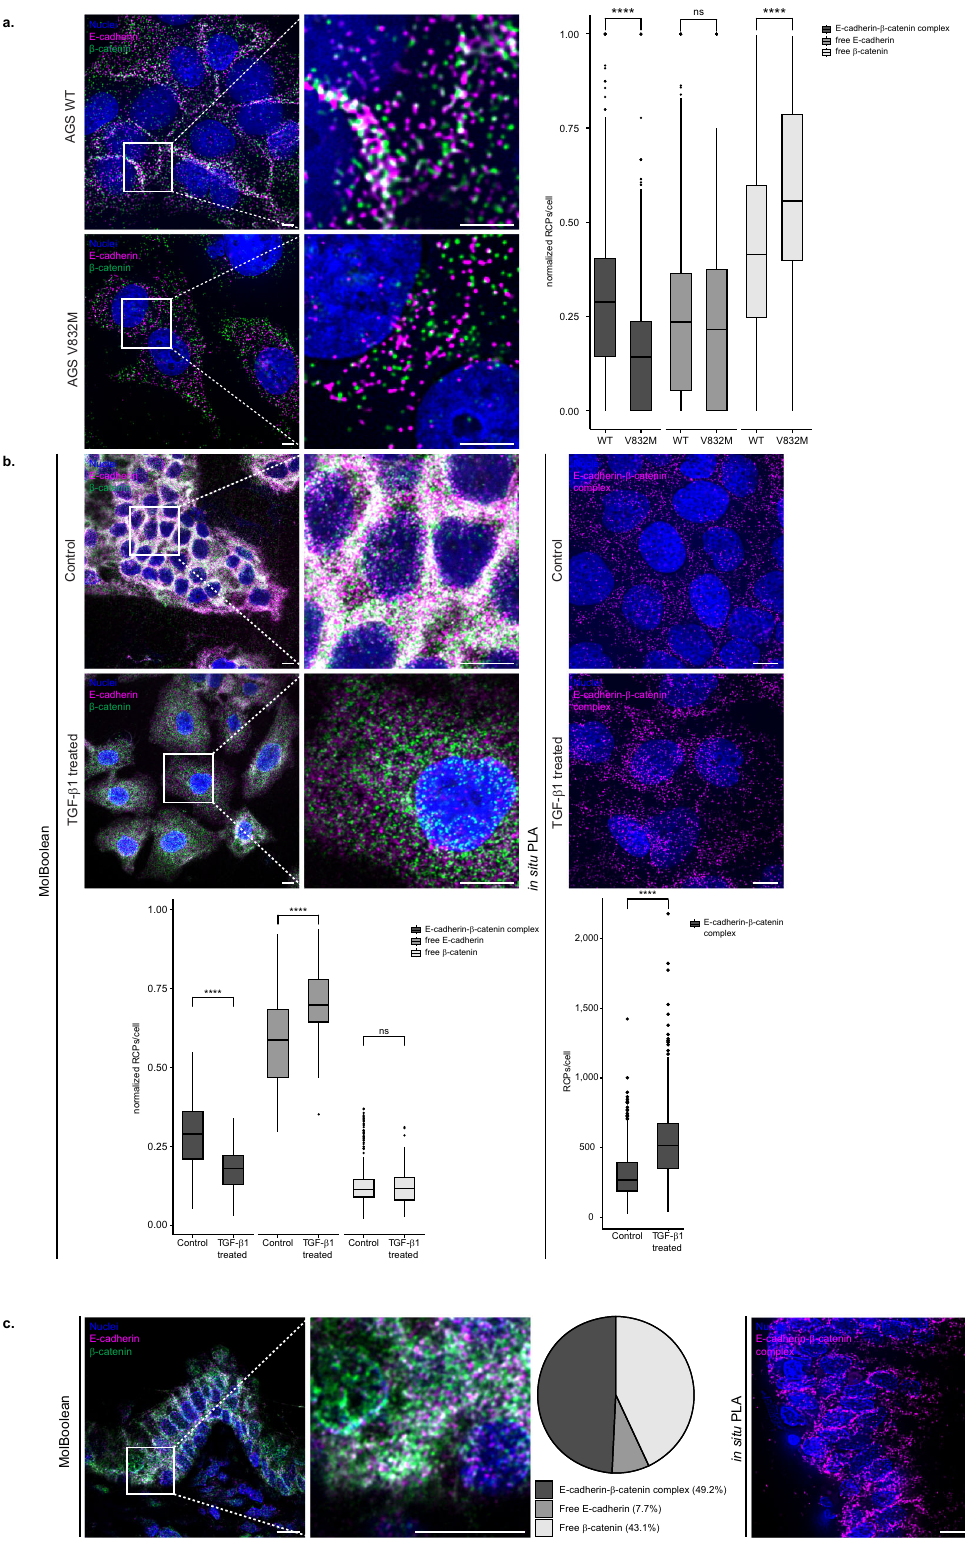
Fig. 4a, bottom panel). Technical controls for MolBoolean and in situ PLA in which either the anti-Emerin, or the anti-Lamin B1 antibody was omitted (omitting controls) are displayed in Supplementary Fig. 4a. tested MolBoolean on an assay that features nuclear interactions: FUS-HNRNPM (Fig. 6b). FUS is a DNA/RNA-binding protein